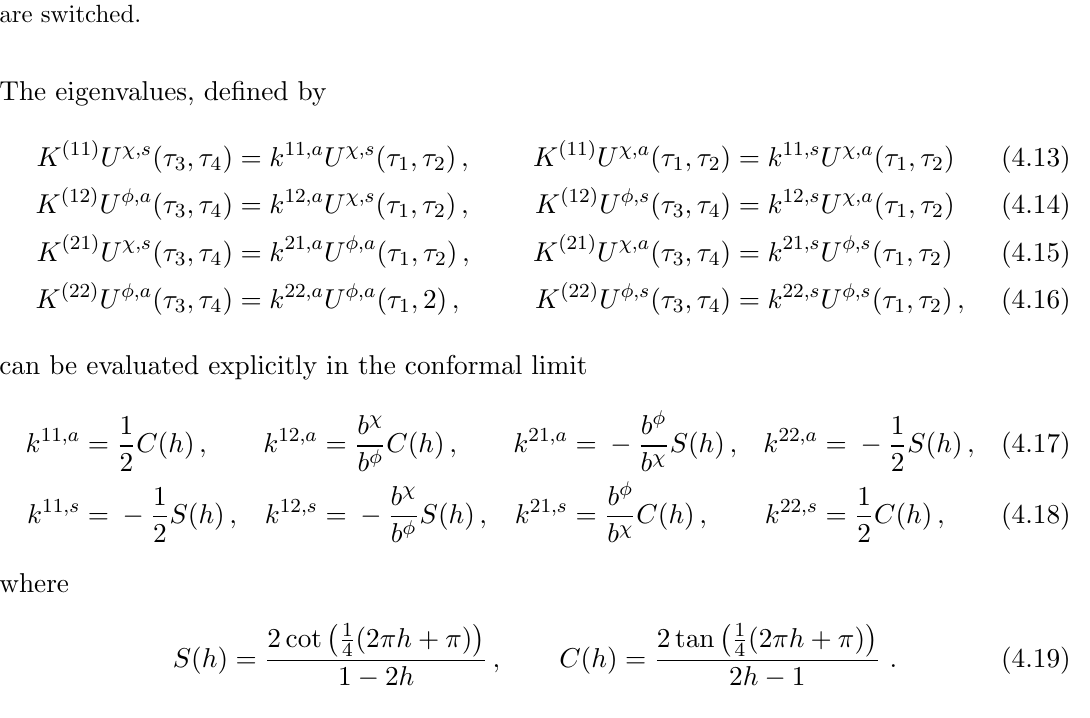
Figure 9 . The red curve are the eigenvalues from diagonalizing the entries of the k ab matrix of the model (4.1). There is another identical copy where the symmetry properties of the eigenfunctions are